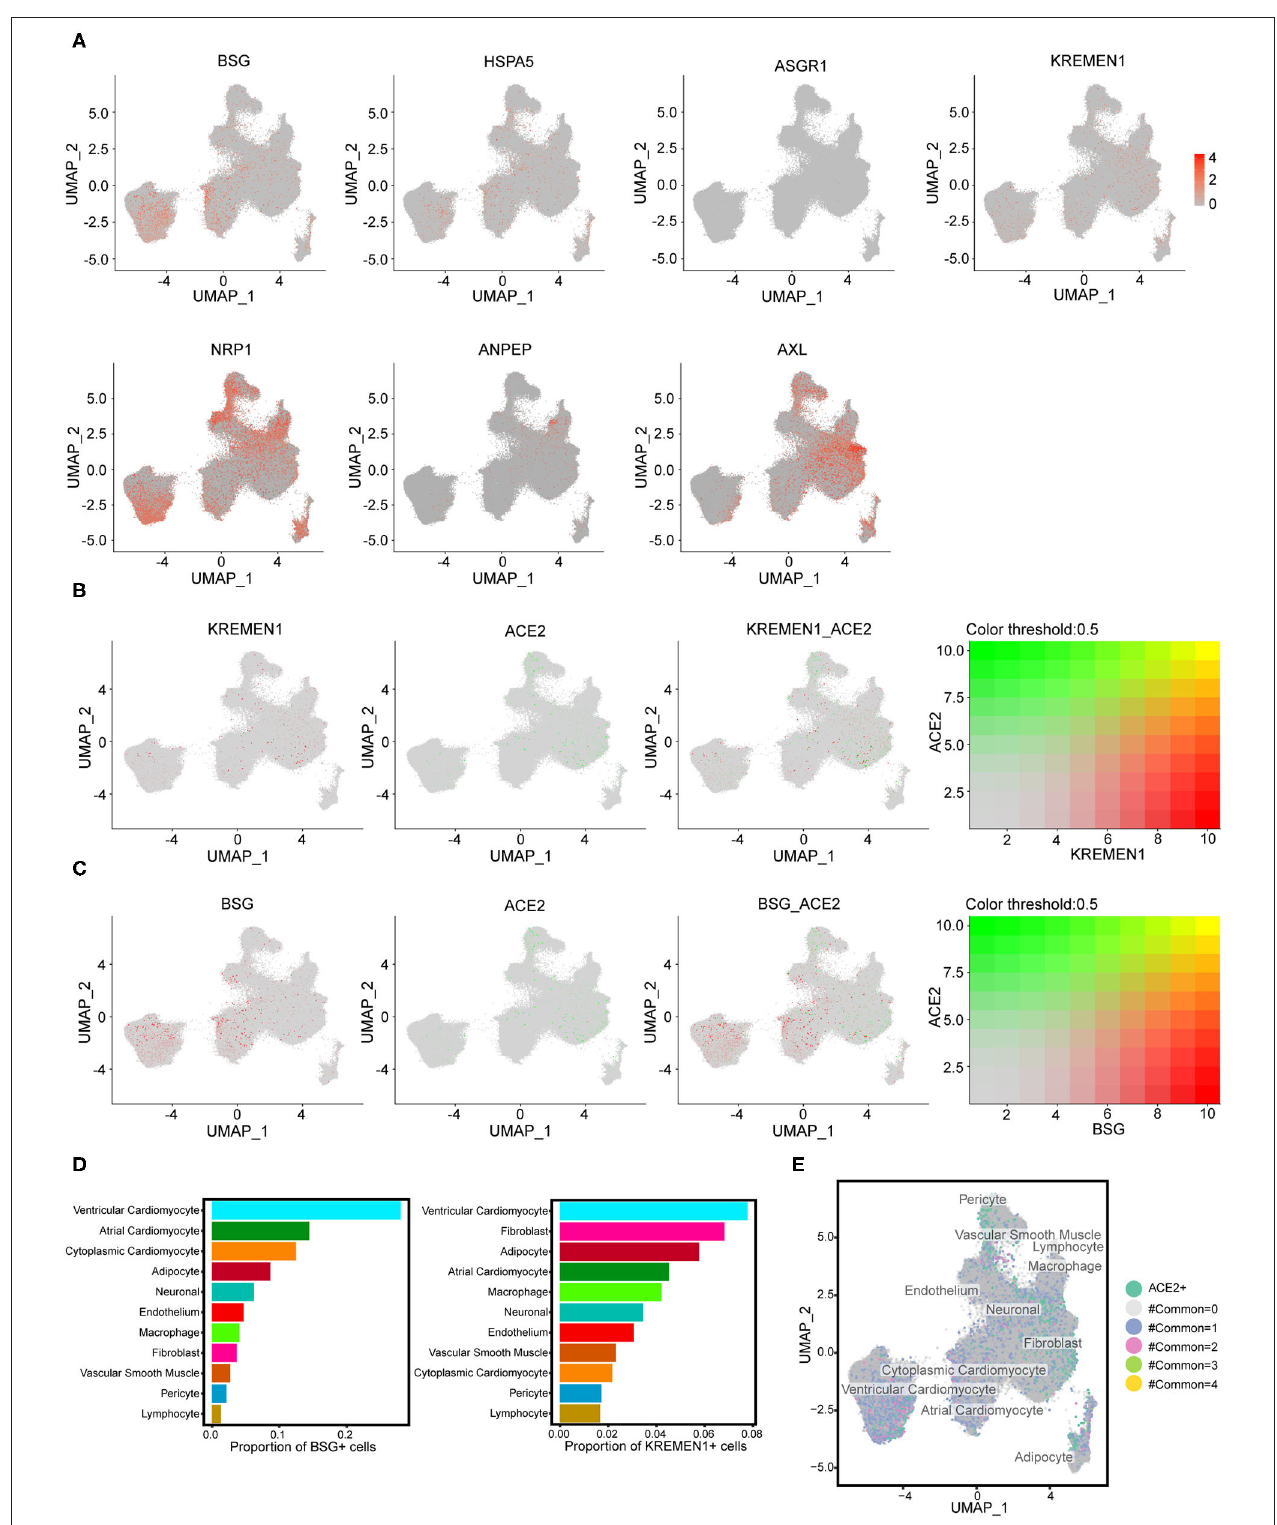
FIGURE 3 | The expression signatures of potential receptors in the human heart. (A) Expression features of potential SARS-CoV-2 receptors (BSG, HSPA5, ASGR1, KREMEN1, NRP1, ANPEP, and AXL) across all cell clusters. (B) The expression distributions of KREMEN1 and its correlation with ACE2. (C) The expression distributions of BSG and its correlations with ACE2. For (B,C) right panels: green represents BSG/KREMEN1 positive cells, red represents ACE2 positive, gray indicates double-negative cells, and yellow indicates double-positive cells. (D) The proportion of BSG-positive or KREMEN1-positive cells in each cell population. (E) The expression characterizations of the four known receptors (ACE2, BSG, HSPA5, and KREMEN1). The numbers represent the receptors with a coexistence state.